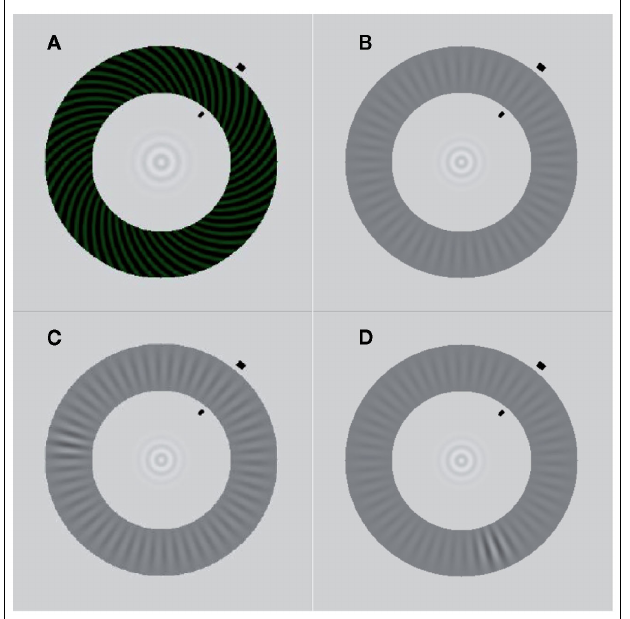
FIGURE 1 | Stimuli. (A) High-contrast spiral pattern (dominant stimulus). (B) Low-contrast radial pattern (target stimulus). (C) Contrast increment in the upper left quadrant of the target stimulus.The induced wave that propagates along the shorter section between trigger and arrival point (black lines) travels along the interhemispheric path. (D) Contrast increment in the lower right quadrant of the target stimulus.The induced wave that propagates along the shorter section between trigger and arrival point travels along the intrahemispheric